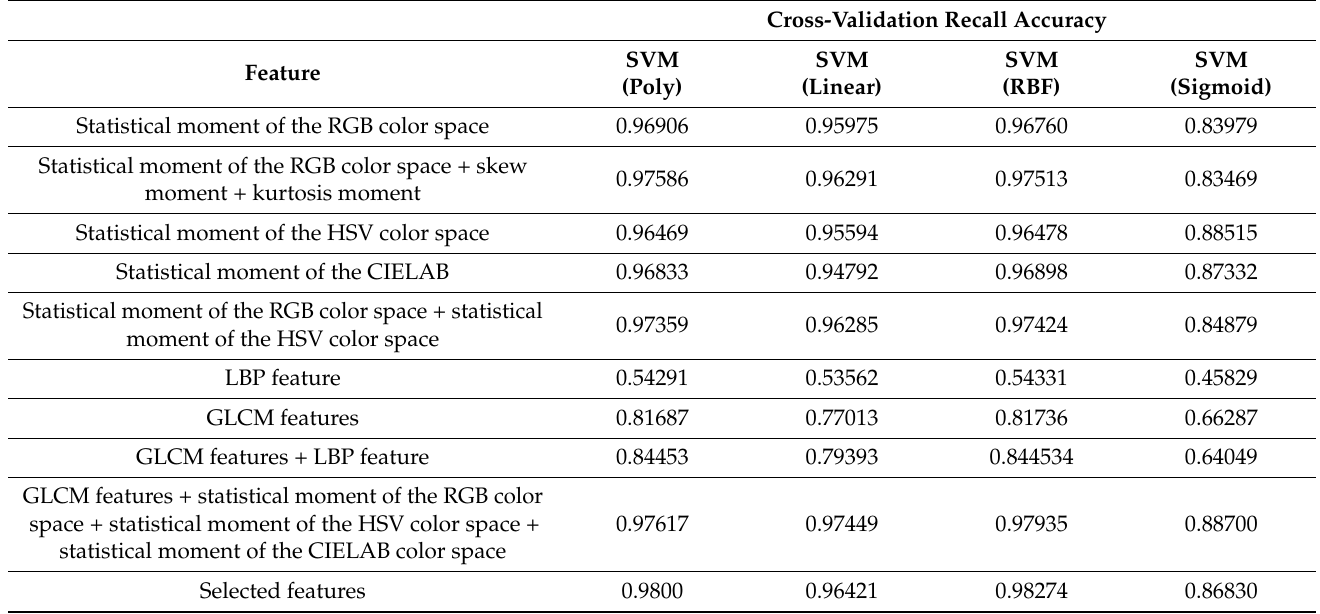
Figure 12. SVM (RBF kernel) receiver operating characteristic (ROC) curve. Table 3. Recall accuracy of the proposed model compared with different feature